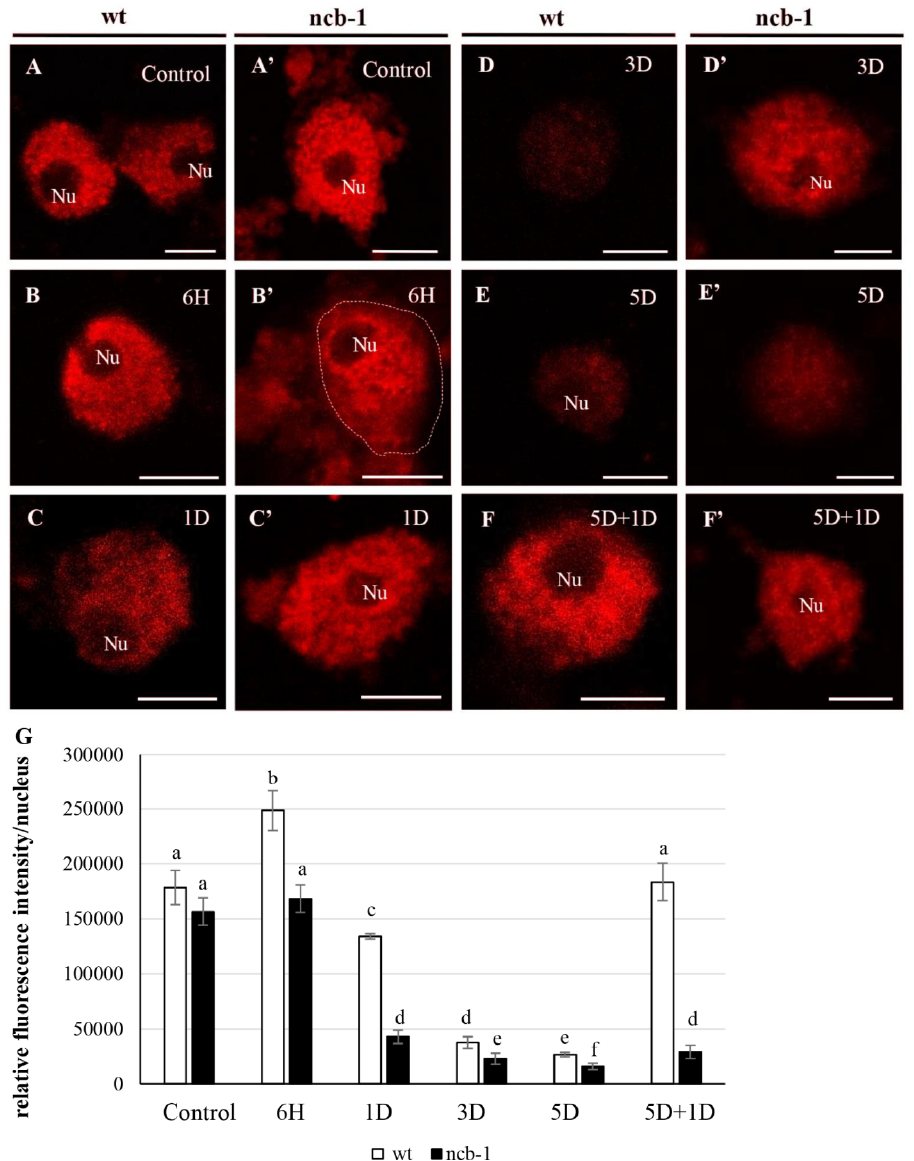
Figure 4. Localization and quantitative analysis of active RNA Pol II in the roots cells Arabidopsis thaliana. Distribution of ser2 of CTD RNA Pol II RNA in wt ( A – F ) and ncb-1 ( A’ – F’ ) in control (Control), hypoxia (6H, 1D, 3D, 5D) and reoxygenation condition (5D + 1D) (indicated in the top right corner of the image). In B’ dashes line indicate nucleus. Histogram shows the quantity of ser2 of CTD RNA Pol II RNA in nuclei in different of stages ( G ). X-axis—6H- hours and 1, 3, 5D—days of hypoxia, 5D + 1D—5 days of hypoxia and 1-day reoxygenation. Variants labeled with the same letters are not significantly different ( p ≤ 0.05). Bar 5 µ